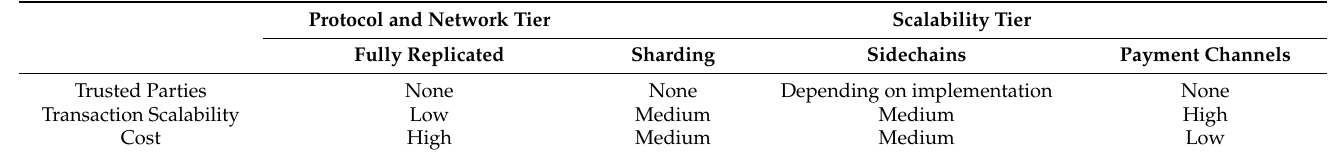
Table 7. Transaction scalability